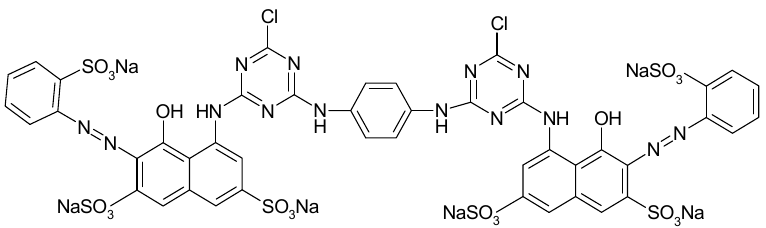
Figure 1. Chemical structure of reactive Brilliant Red HE-3B dye —CI 25810 .